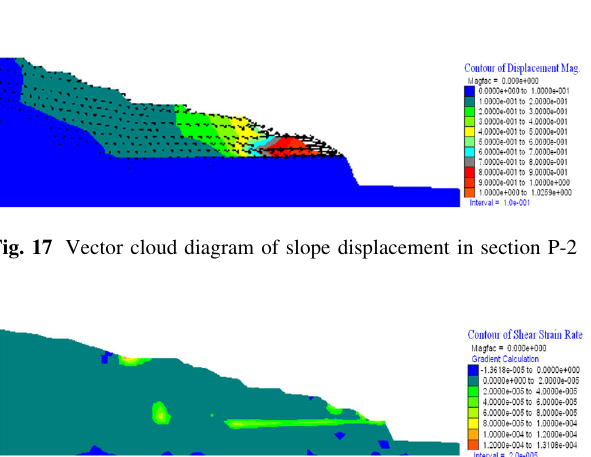
Fig. 16 Calculation model for section